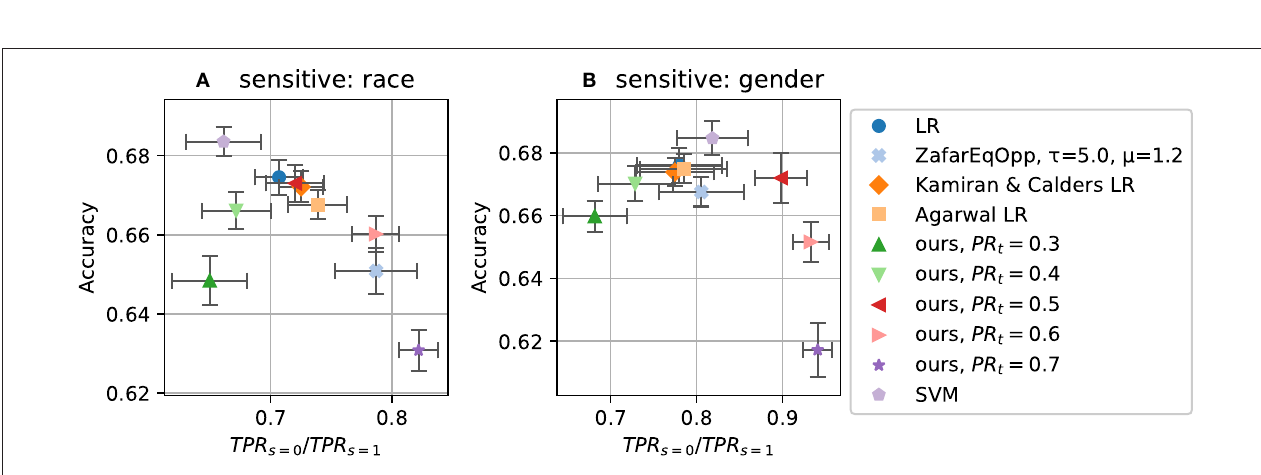
FIGURE 4 | Accuracy and fairness (with respect to equality of opportunity ) for various methods on ProPublica dataset. (A) : using race as the sensitive attribute; (B) : using gender. A completely fair model would achieve a value of 1.0 in the x-axis. See Figures 5A,B on how these choices of PR setting translate to TPR s = 0 vs TPR s = 1